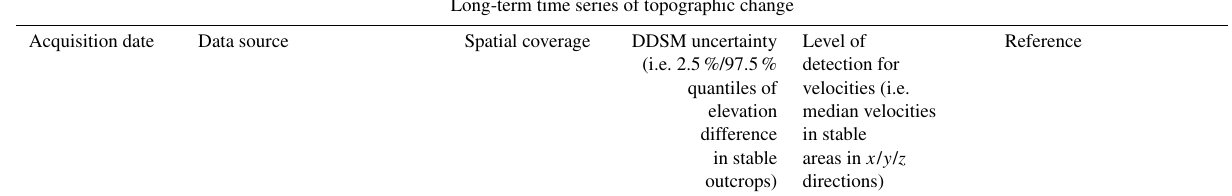
Table 2. Metadata for the presented topographic data. Values for differential digital surface model (DDSM) uncertainty and level of detection refer to the DDSM or DSM pair of the given and previous year, respectively (in ma − 1